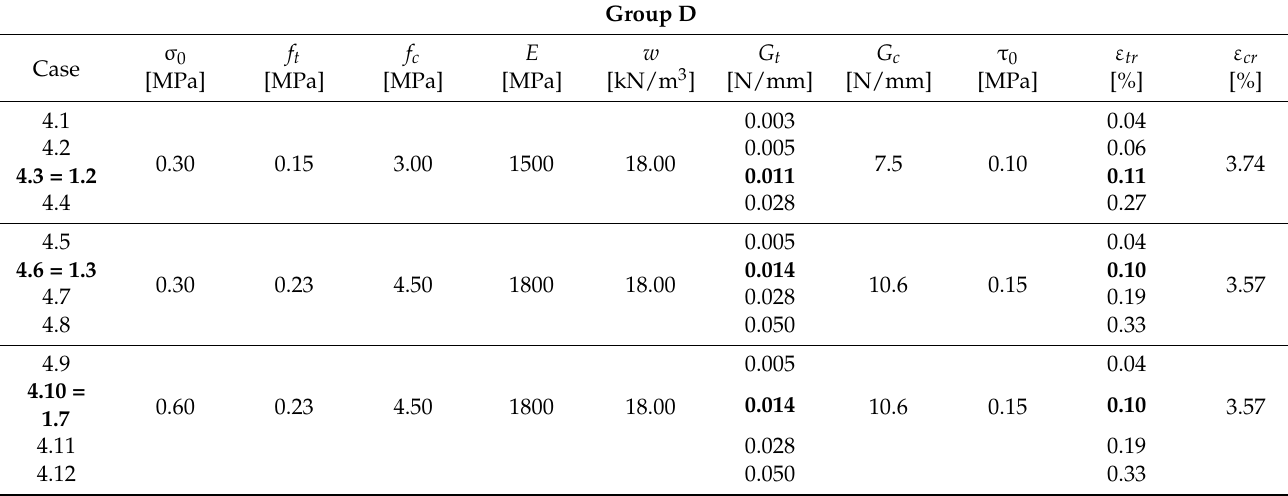
Table 6. Mechanical properties used in the sensitivity analyses for Group D. Group